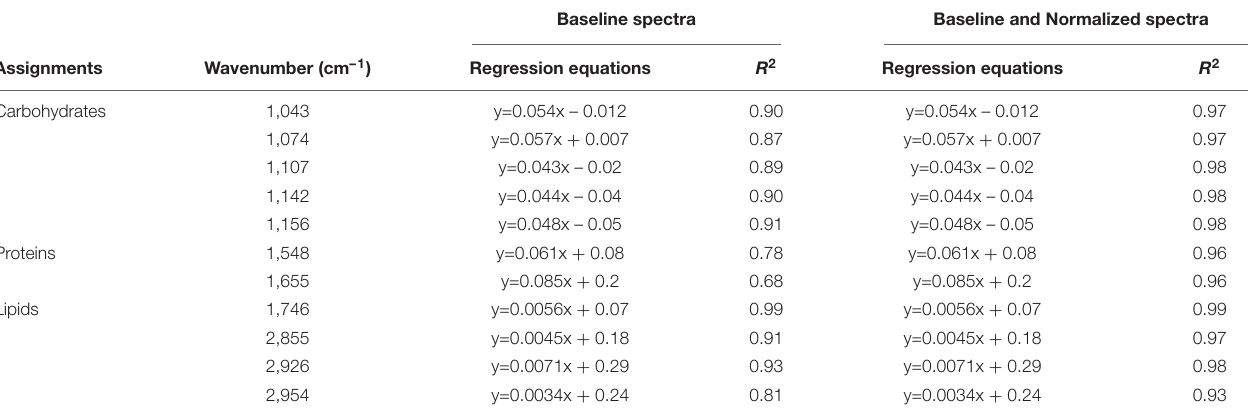
TABLE 2 | Regression equations and coefficients of determination (R 2 ) of the correlations between FTIR absorbance measured at the different wavenumbers and standard biochemical quantifications considering either baseline-corrected spectra or baseline and normalized-corrected spectra performed on Pt4. Baseline spectra Baseline and Normalized